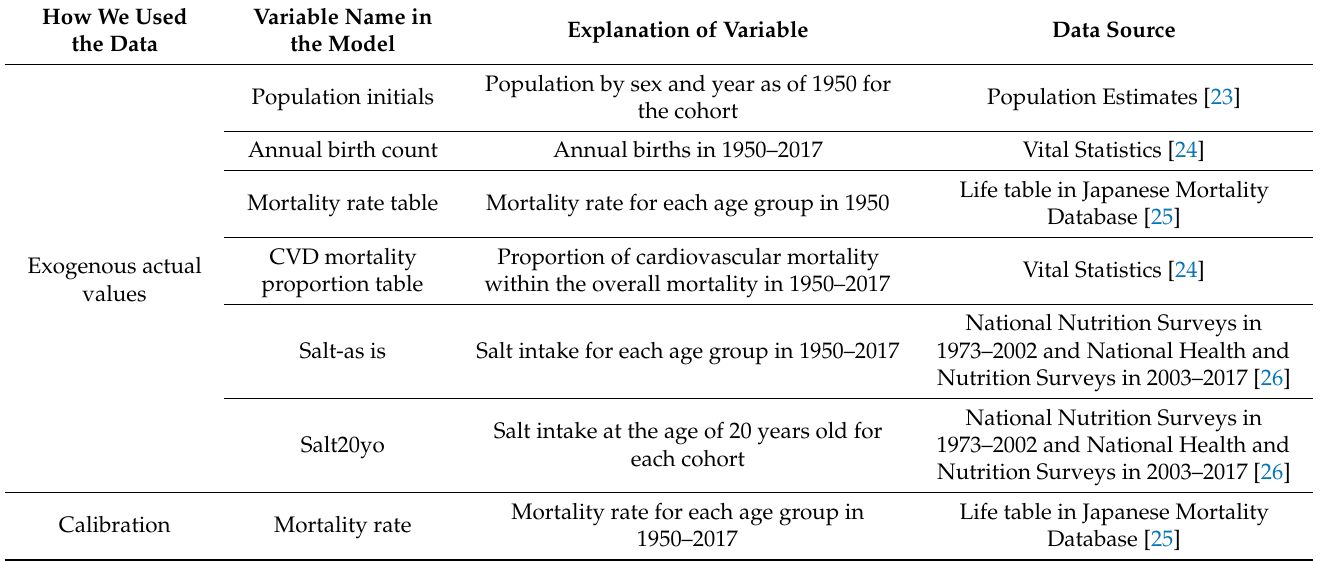
Table 1. Sources of published data used in the